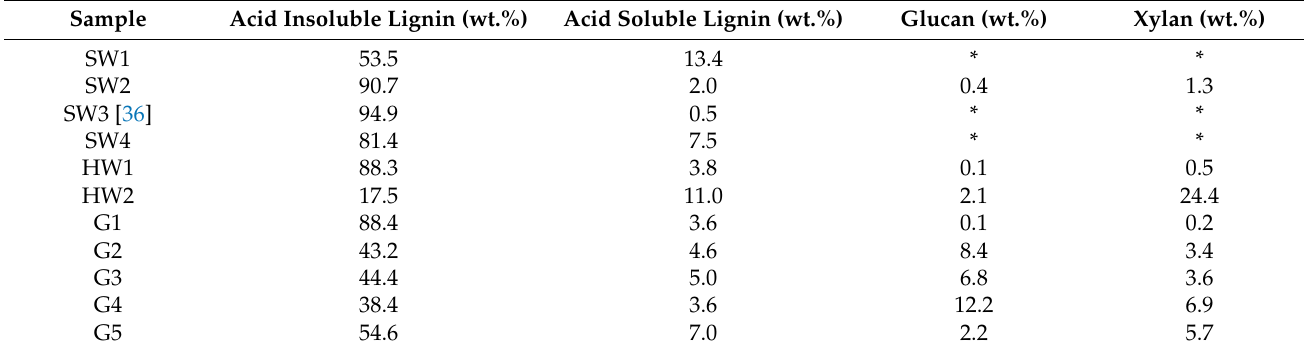
Table 2. Lignin and carbohydrate contents of the samples